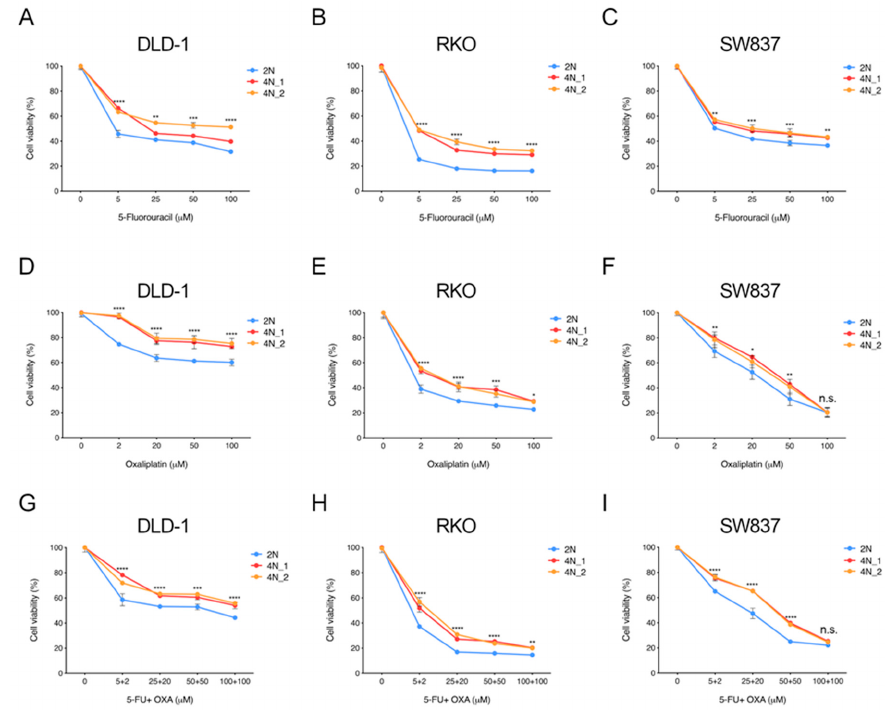
Cellular viability response upon treatment with first-line chemotherapeutic agents. Dose-response curves for increasing concentrations of 5-fluorouracil ( A – C ), oxaliplatin ( D – F ) and the combination of both compounds ( G – I ) in one 2N and two 4N clones of DLD-1, RKO and SW837 CRC cell lines. Each cellular viability was normalized based on its corresponding non-treated counterpart. Fitted curves for two replicates from three independent experiments are plotted. ANOVA test with post-hoc Tukey was performed to test significance. Data are reported as means ± SD. n.s., not significant; *, p < 0.05; **, p < 0.01; ***, p < 0.001; ****, p <